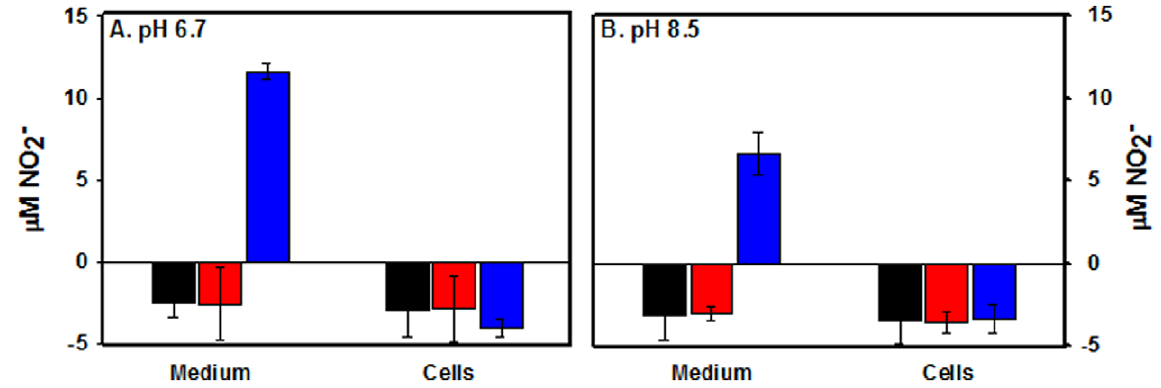
Figure 3. Export of nitrite in the absence of NarK2. Aerobic cultures of RVW3 were incubated with nitrate at pH 6.7 (A) or pH 8.5 (B). Untreated controls – black bars. With oxidized benzyl viologen – red bars, or with dithionite-reduced benzyl viologen – blue bars. Nitrite levels were measured after 90 min in medium or in cells. The standard deviation is indicated.